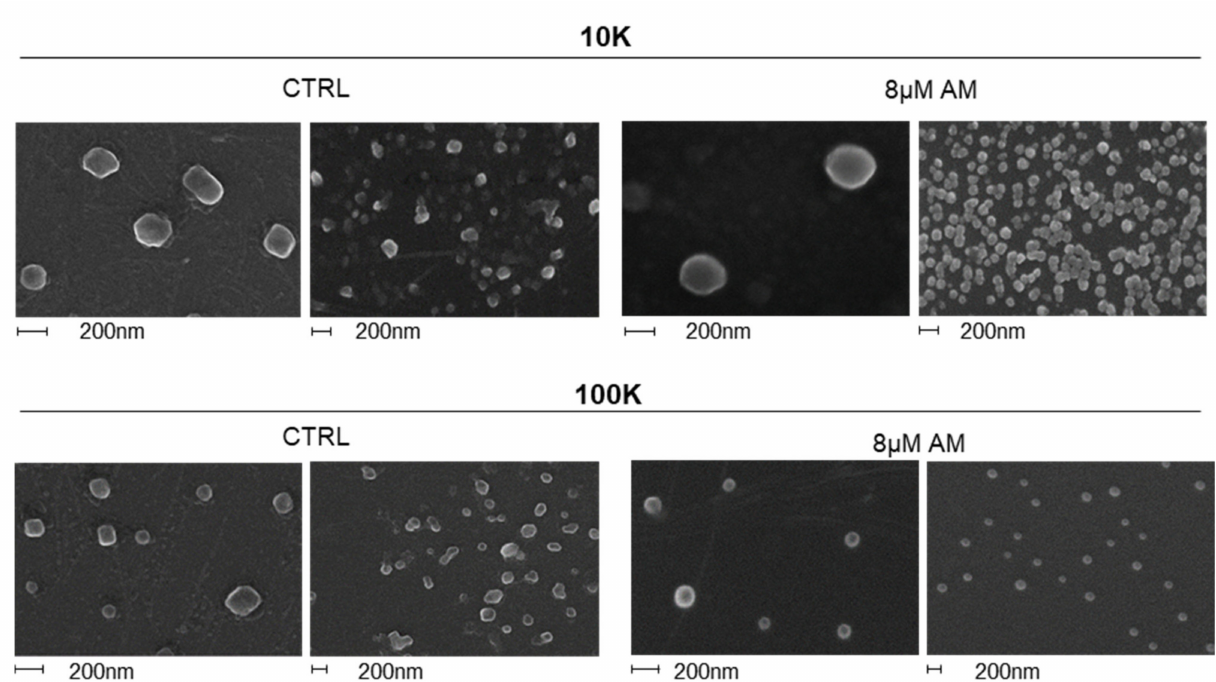
Figure 5. Scanning electron micrographs of EVs . EVs were isolated by dUC, fixed with 2.5% glutaraldehyde in PBS, sedimented onto glass coverslips, allowed to dry at room temperature. Images were obtained using a field emission gun electron scanning microscope after Cr